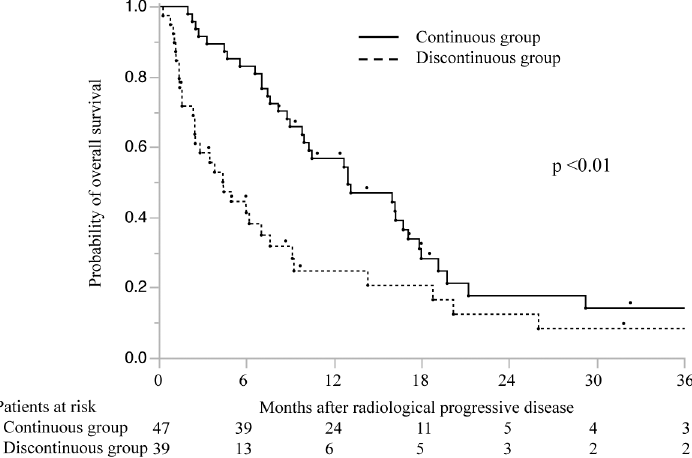
number of patients at risk.